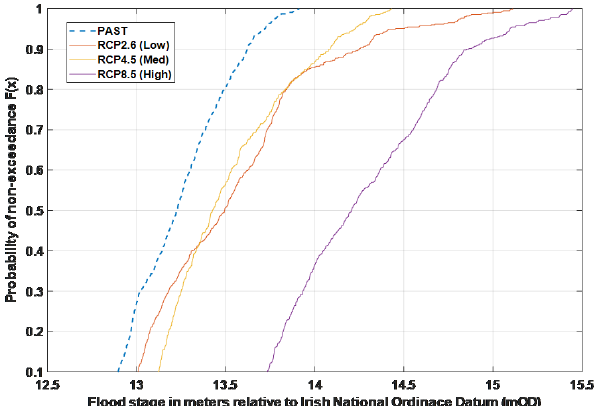
Figure 10. Comparison of the non-parametric cumulative distribu- tion function (CDF) plots for the past and future RCM emission scenarios using the MPI-ESM-LR RCM data sets at h values below the 95th percentile excluded (annual maxima